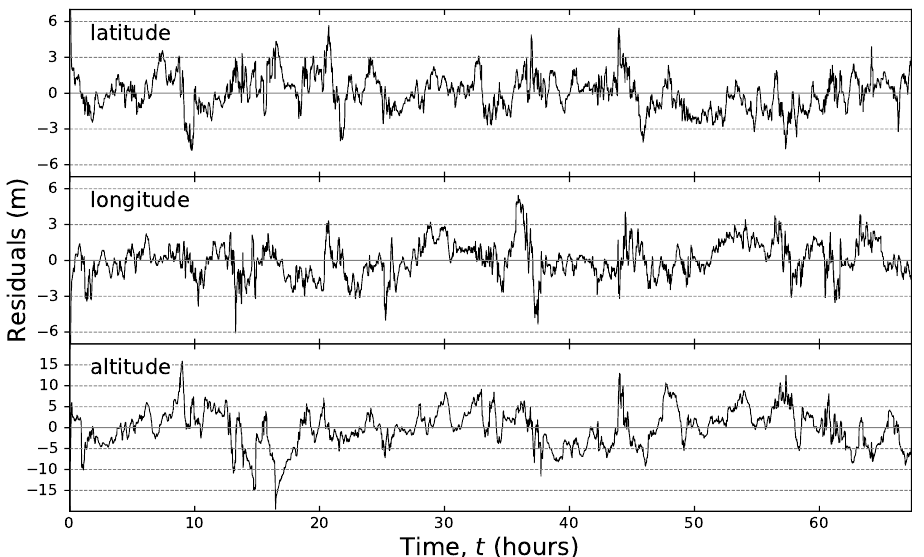
Figure 3. Residuals of latitude, longitude and altitude time-series at Port Douglas, Australia. The grey dashed lines guide the eye and highlight the mean-reverting nature of the